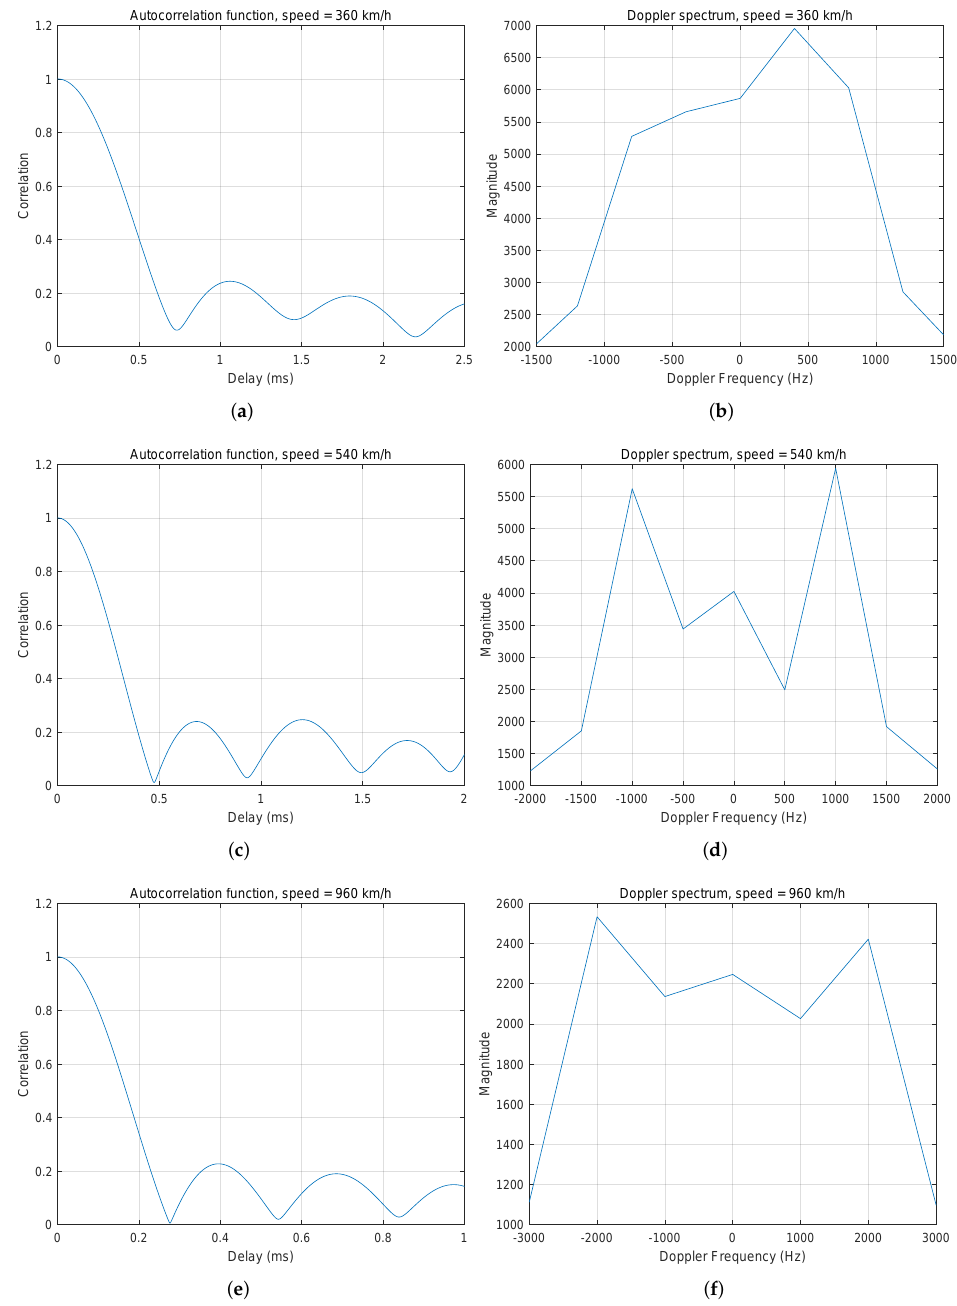
Figure 5. The autocorrelation function and the Doppler spectrum for the NLOS component: ( a , b ) v = 360 km/h; ( c , d ) v = 540 km/h; ( e , f ) v = 960